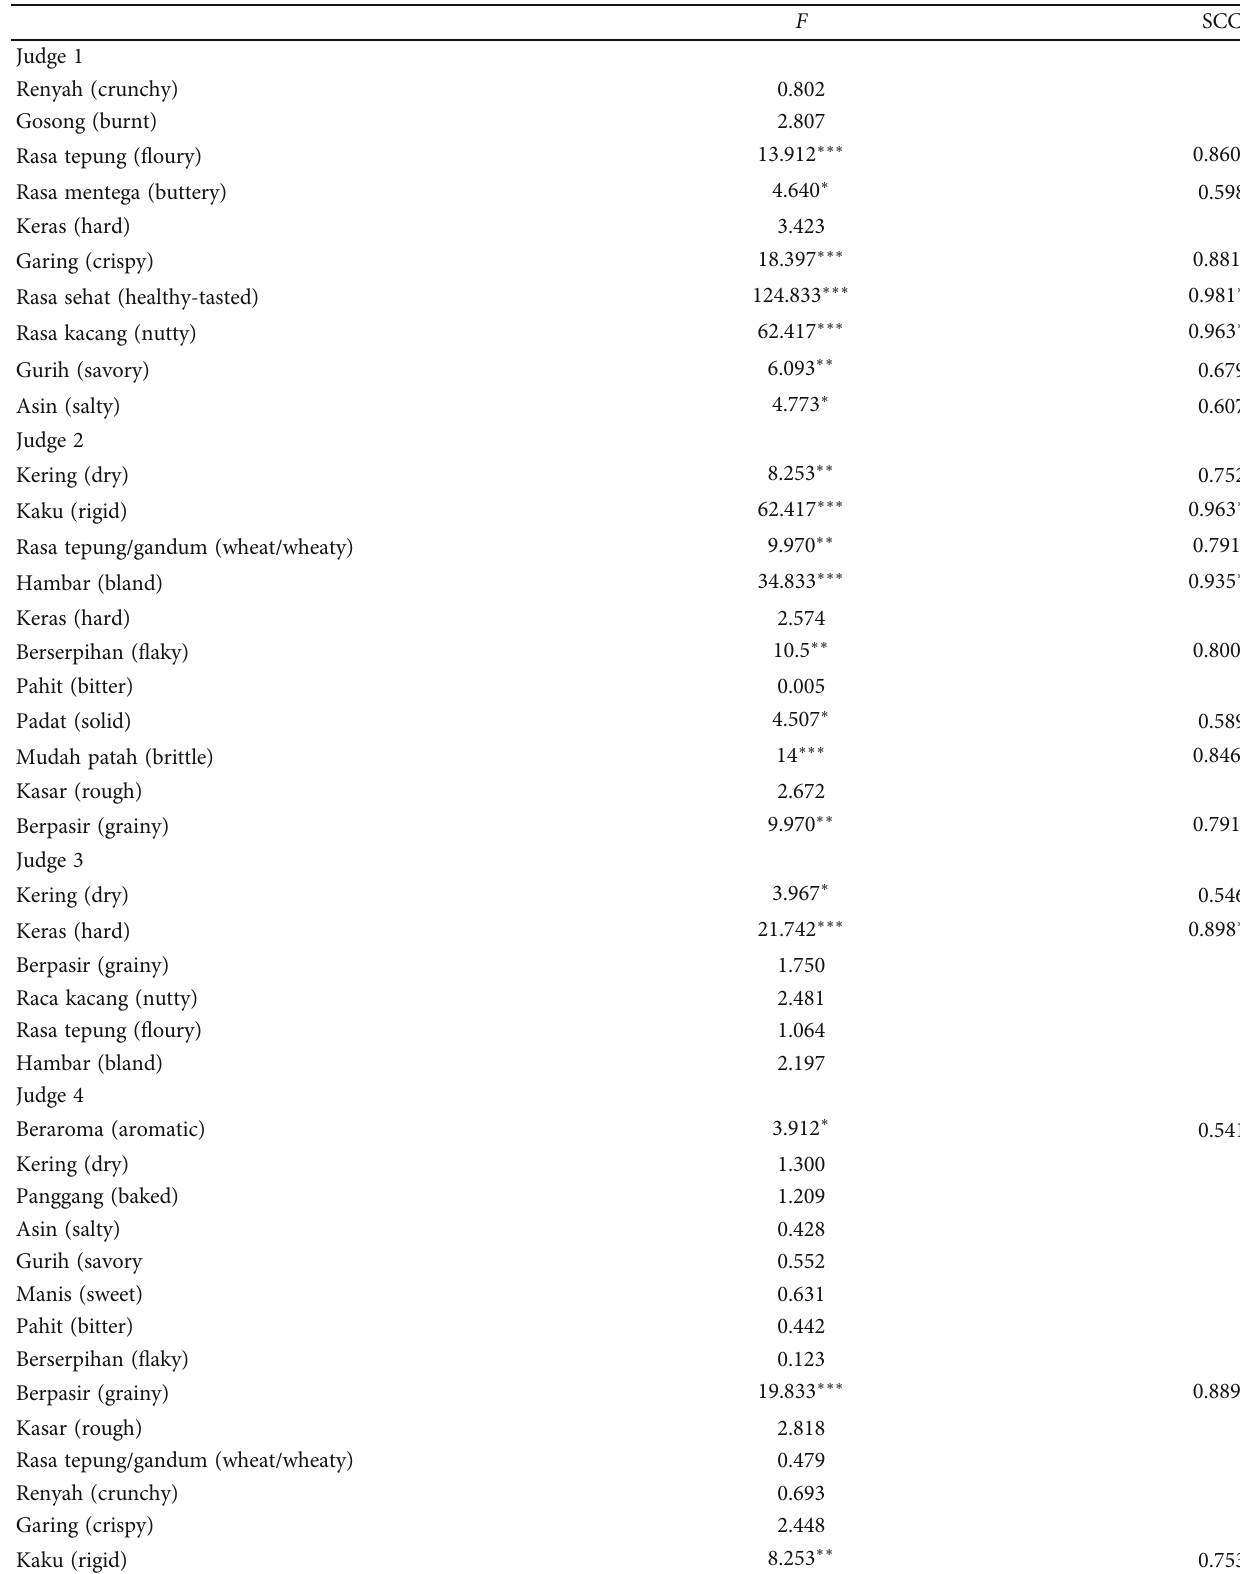
Table 3: F -values ( P < 0 : 05 for ANOVA) and SCC values ( P < 0 : 05 ) for Spearman ’ s correlation test on sensory attributes from each Indonesian judge in the Flash pro fi